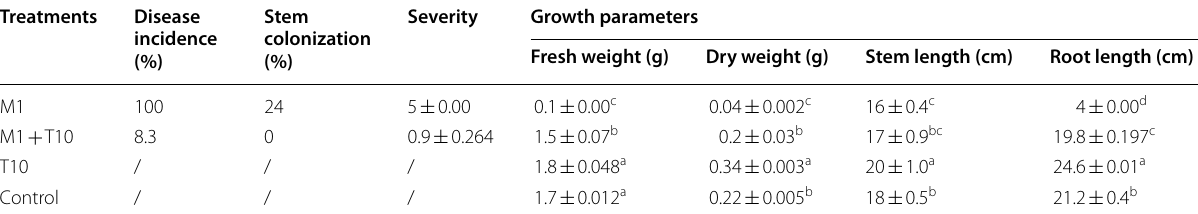
Table 2 Effect of Trichoderma longibrachiatum on charcoal rot disease of lentil, and plant growth parameters under greenhouse conditions